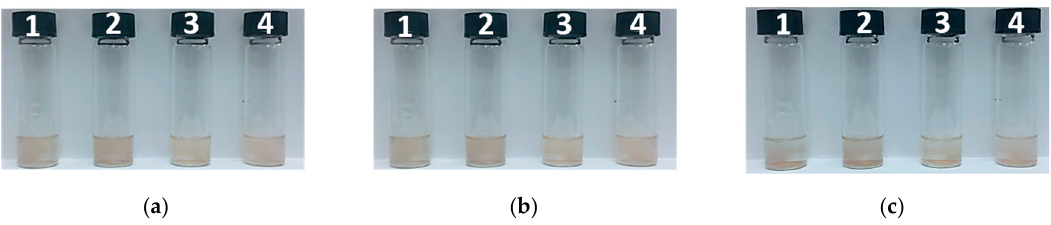
Figure 4. Stability test of as-synthesized Au NPs, ( a ) 1 hour, ( b ) 5 hours, ( c ) 10 hours. Solvent: 1 – DI water, 2 – methanol, 3 – ethanol, 4 – acetone.